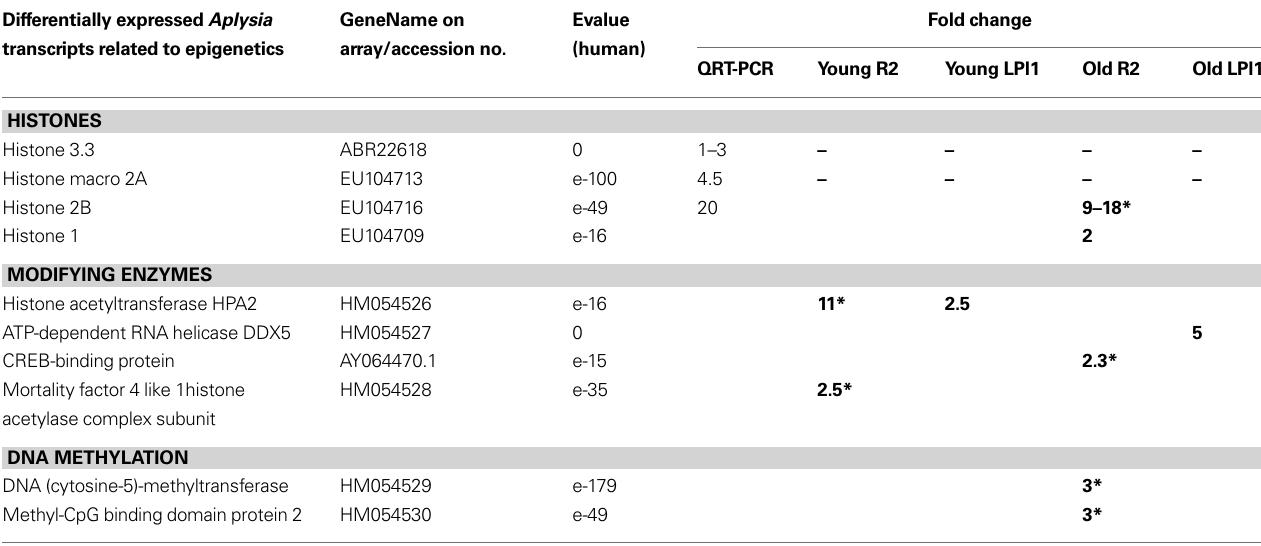
Table 3 | Neuron-specifi c changes in expression of selected genes related to chromatin remodeling from two identifi ed cholinergic neurons: R2 and